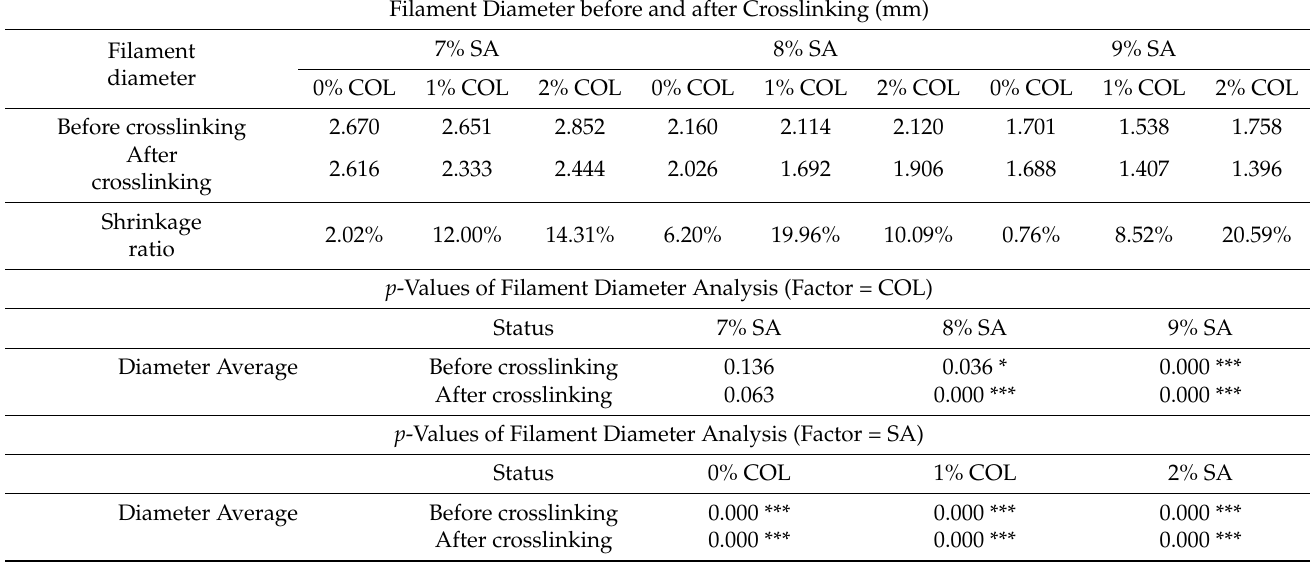
Table 2. Statistical analyses for merged